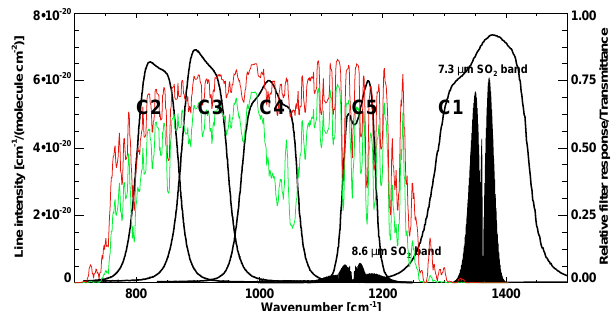
FIGURE 3. HITRAN line intensities of the two main SO 2 absorption bands shown together with the Figure 3. HITRAN line intensities of the two main SO 2 absorption relative response functions of the five “Cyclops” channels (filters) used. The slant-path transmittance bands shown together with the relative response functions of the five betweenthecameraandtargetatrangesof (cid:24) 38km(greenline)and (cid:24) 6km(redline)at5cm (cid:0) 1 resolution calculated from MODTRAN over the region 700–1400 cm (cid:0) 1 (7–14 (cid:22) m) for a standard US atmosphere “Cyclops” channels (filters) used. The slant-path transmittances be- arealsoshown.Notethatthe7.3 (cid:22) mchannel(C1)isopaqueandtheinfluenceofthe9.6 (cid:22) mO 3 bandon tween the camera and target at ranges of ∼ 38km (green line) and the10.1 (cid:22) mchannel(C4)decreasesforshorterranges. ∼ 6km (red line) at 5cm − 1 resolution calculated from MODTRAN over the region 700–1400cm − 1 (7–14µm) for a standard US atmo- sphere are also shown. Note that the 7.3µm channel (C1) is opaque and the influence of the 9.6µm O 3 band on the 10.1µm channel (C4) decreases for shorter ranges. 35